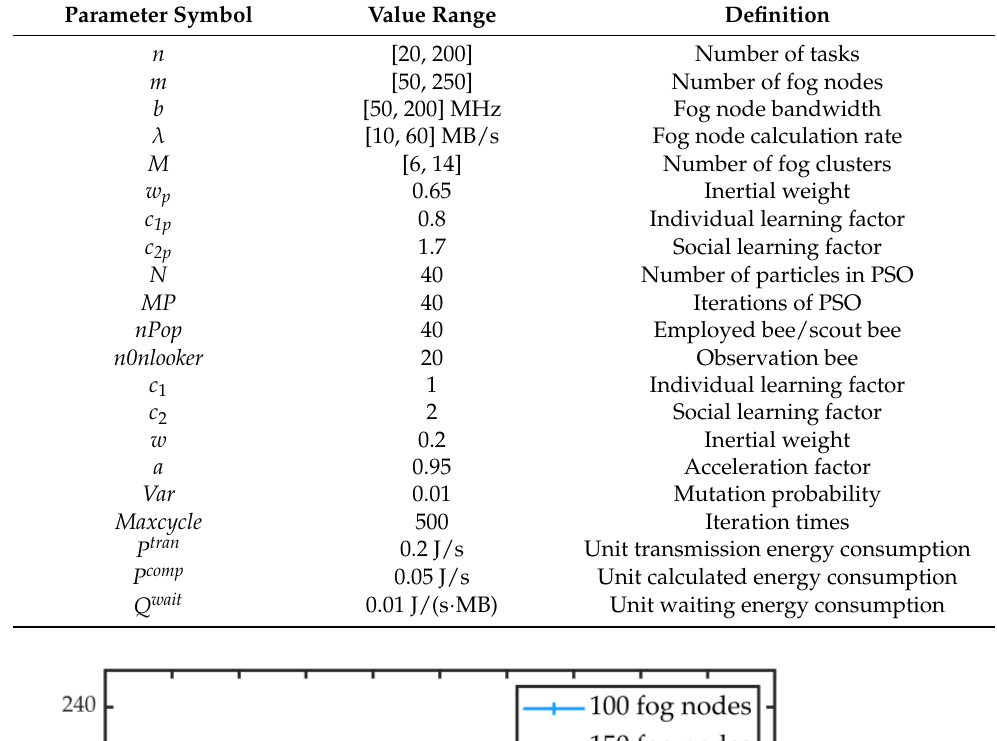
Table 3. Resource-scheduling algorithm simulation parameter settings.